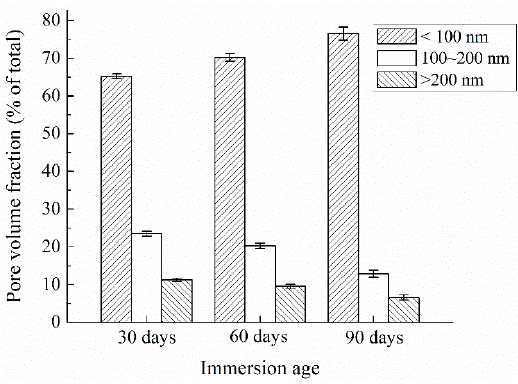
Figure 4. Changing of pore structure of concrete as immersed in ultrapure water (nitrogen